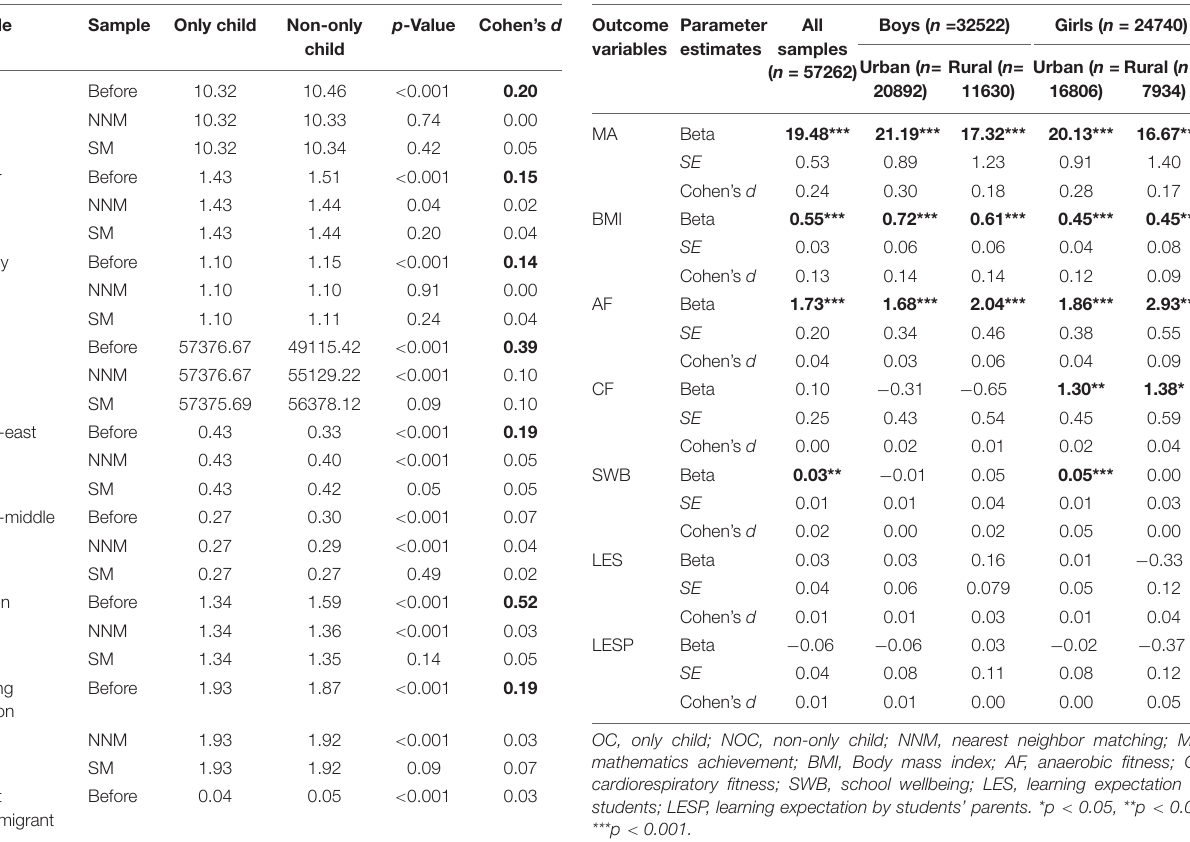
TABLE 2 | Differences in demographic characteristics before and after matching. TABLE 3.1 | The differences of OC and NOC using NNM.